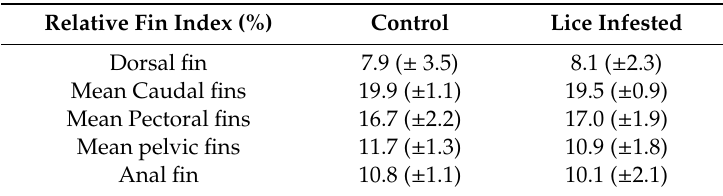
Table 3. Mean relative fin index (%) of Atlantic salmon ( Salmo salar ) fin for both control and infested fish groups previous to the experiment ( ± standard